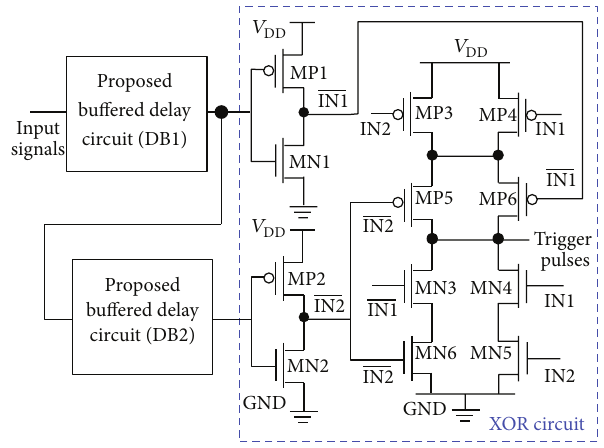
Figure 9: Proposed trigger pulse